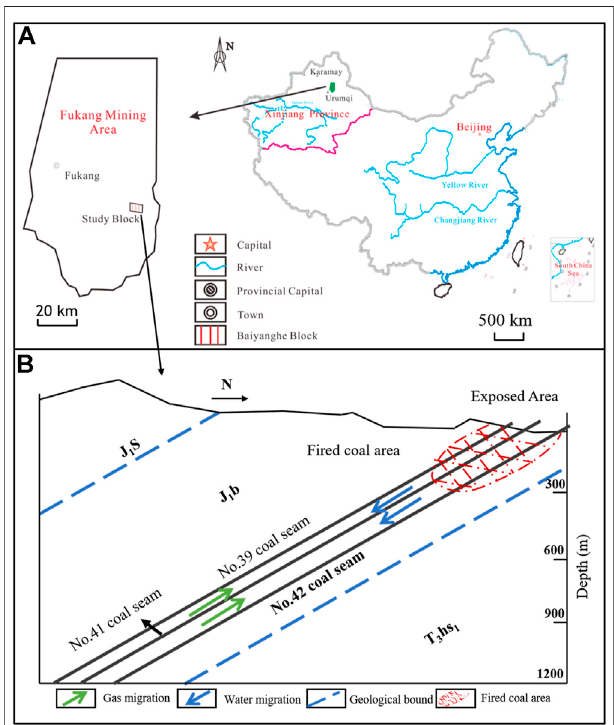
FIGURE 1 | Location and reservoir accumulation diagram of the Baiyanghe mining area: (A) the location, (B) the reservoir accumulation